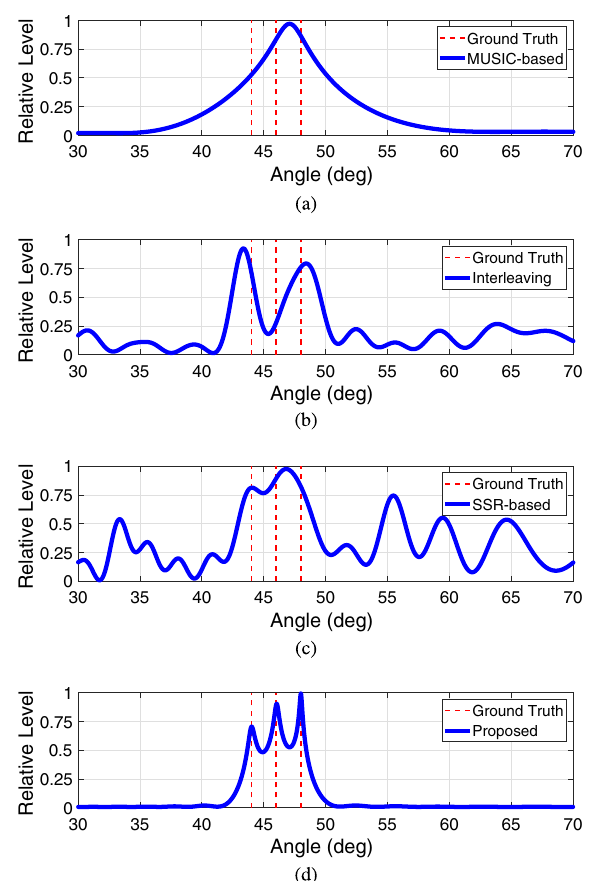
Fig. 7 Angular resolution comparison. a MUSIC-based method; b Interleaving frame structure-based method; c The SSR-based method; d The proposed